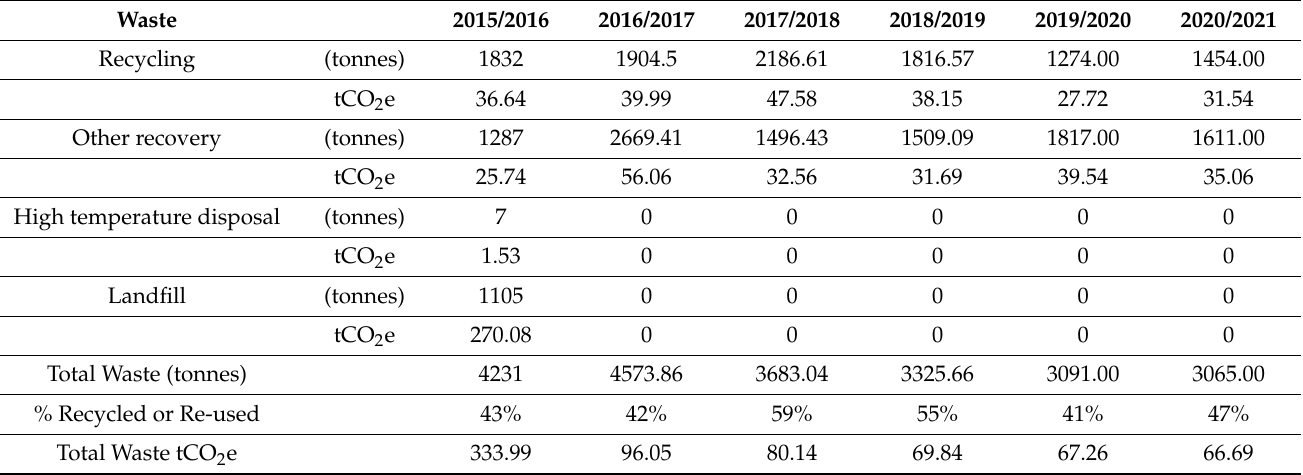
Table A1. Page 44 of UHCW Annual report 2018–2019 and page 32 of the UHCW Annual